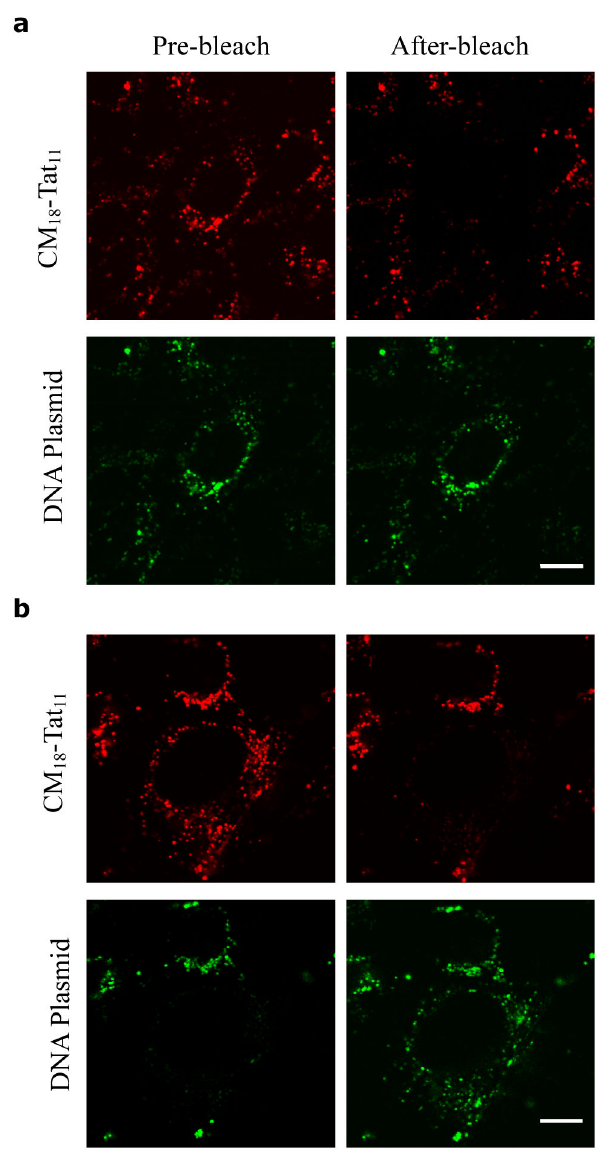
Figure 4. Acceptor photobleaching assay. ( a , b ) acceptor photobleaching experiments on putatively non-transfected ( a ) or trasfected ( b ) cells. For both conditions, the first row of images shows CM -Tat -atto633 cell signal before and after a 18 11 scanning bleaching of the whole cell with a 633nm laser at full power, while the second row shows the same for Cy3-plasmid DNA signal. Scale bar: 10